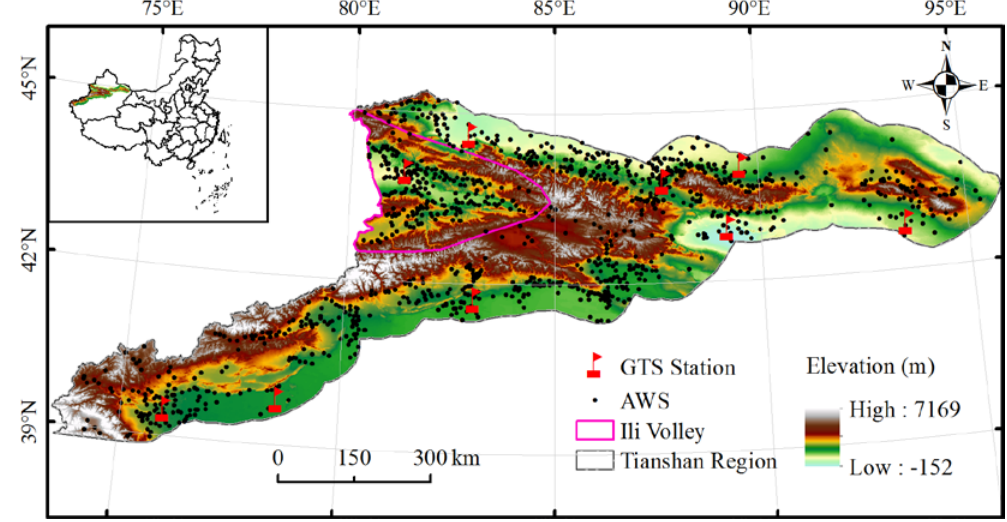
Figure 1. Digital elevation model (DEM) and distribution of the observation stations on a map of the Tianshan Mountains. The black dots and red flags represent automatic weather stations (AWSs) and Global Telecommunication System (GTS) stations, respectively.